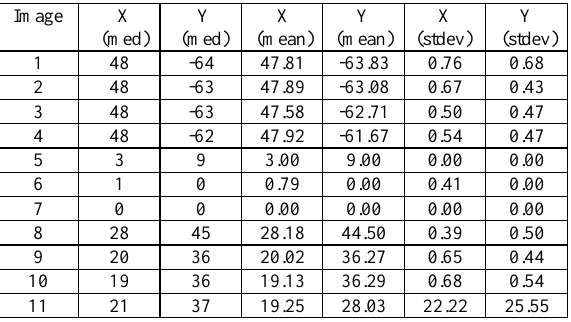
Table 1. Median, mean and standard deviation of each image with respect to image 7.